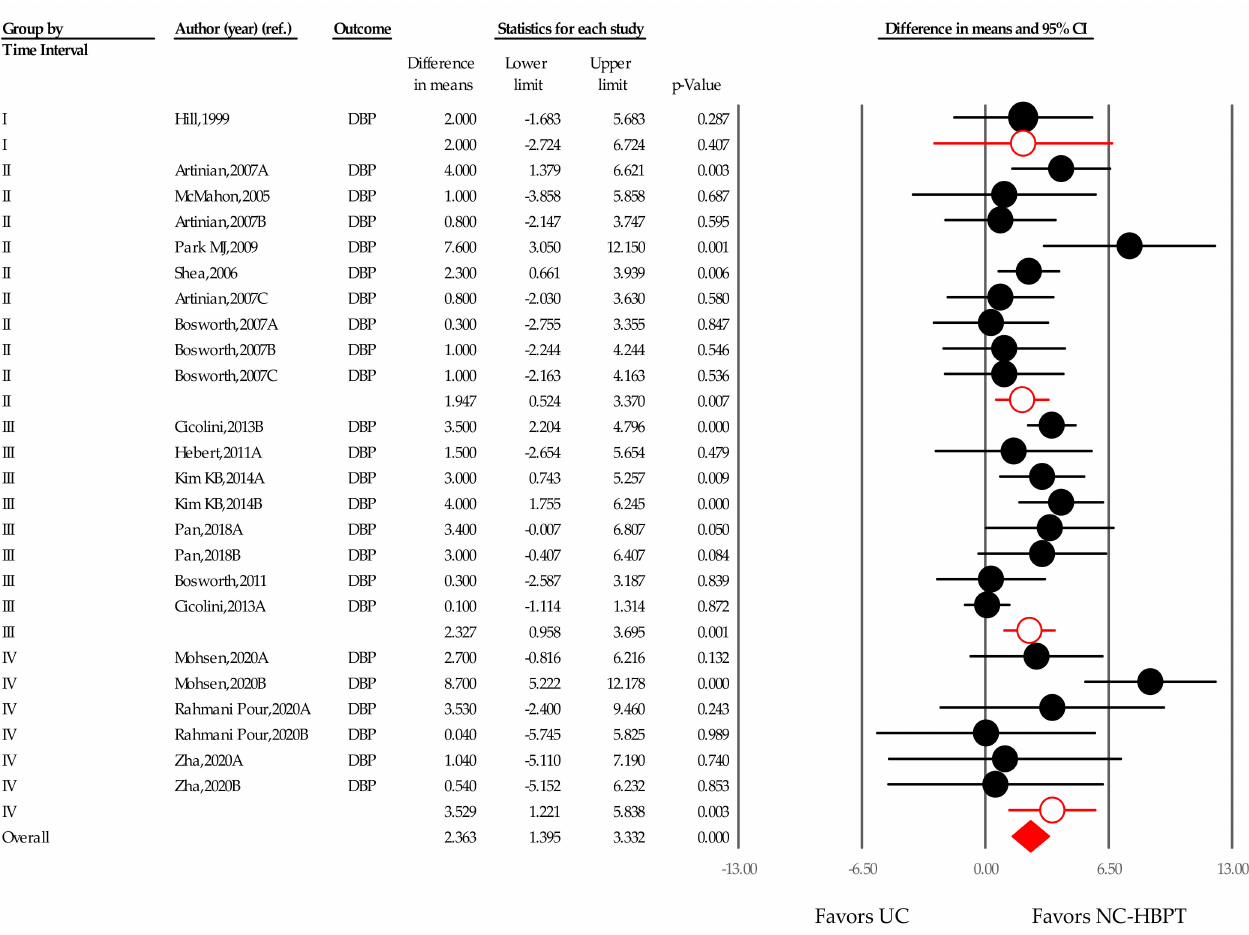
Figure 6. Difference in means of office systolic blood pressure changes over time. Notes. Point estimate of individual study ( ● ); Subgroup ( ○ ); Summary effect size ( ◆ ); DBP, diastolic blood pressure; UC, usual care; NC-HBPT, nurse-coordinated home blood pressure telemonitoring.